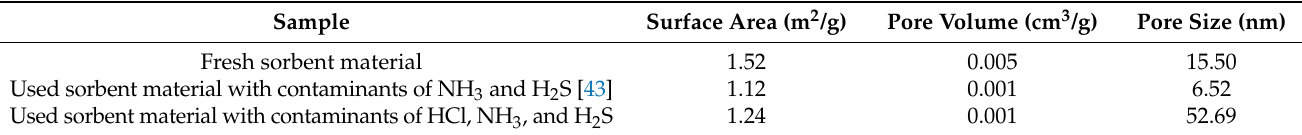
Table 2. BET surface area, BJH pore volume, and pore size of the fresh material used sorbent material.